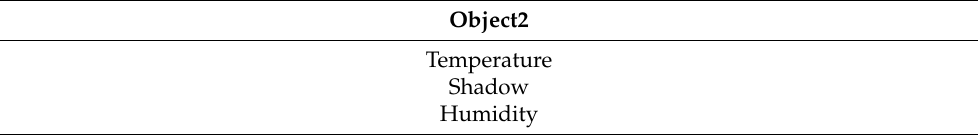
Table 9. Query result for scenario 2, using Protégé 5’s Pellet reasoner, execution time was 38 ms.